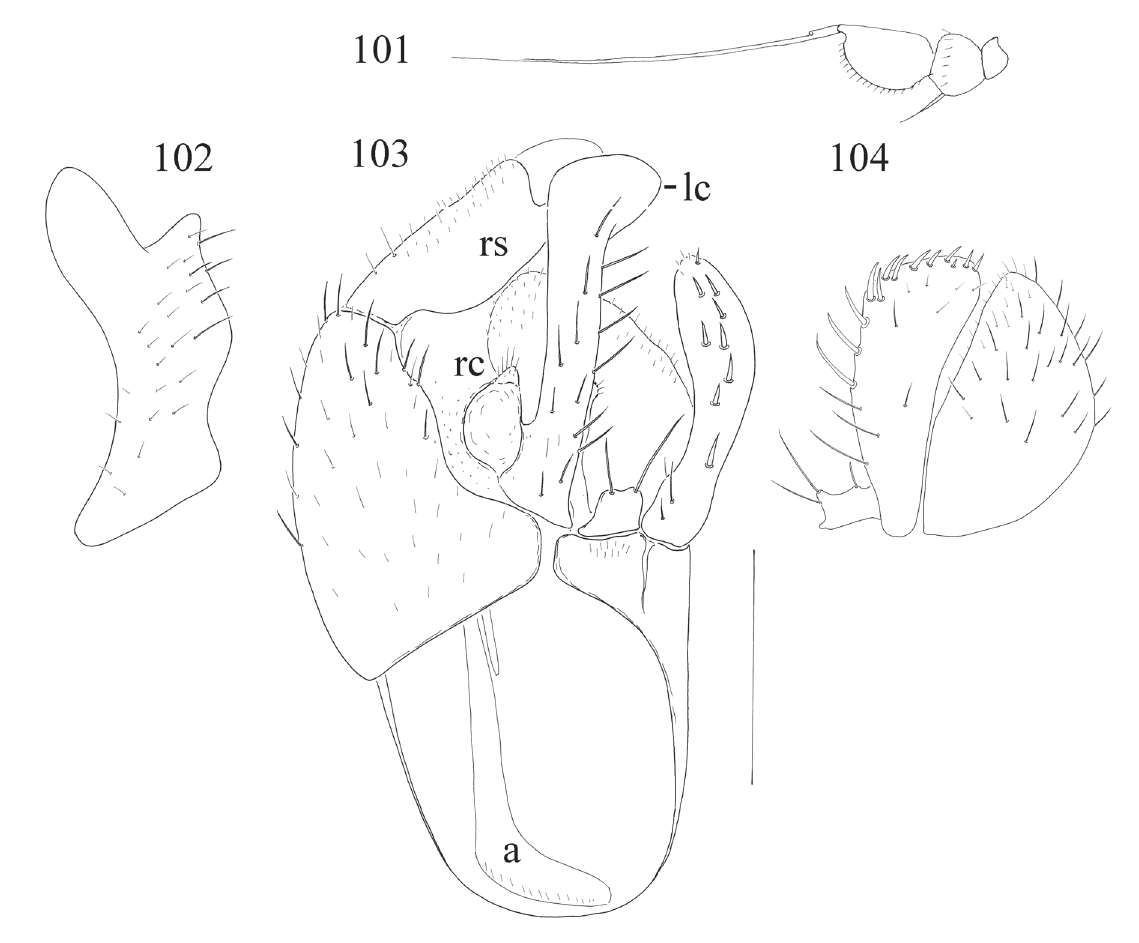
Figs 101-104. Drapetis mandai sp. nov., ♂. 101. antenna, lateral view. 102 . right surstylus, dorsal view. 103 . epandrium and cerci. 104 . left surstylus, lateral. Scale bar= 0.1